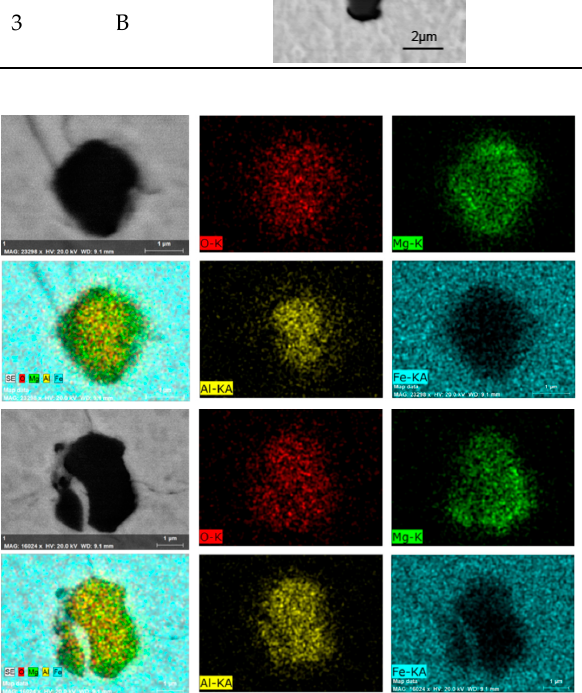
Figure 2. Element mapping of MgO-rich spinel inclusions in the group of HALC.